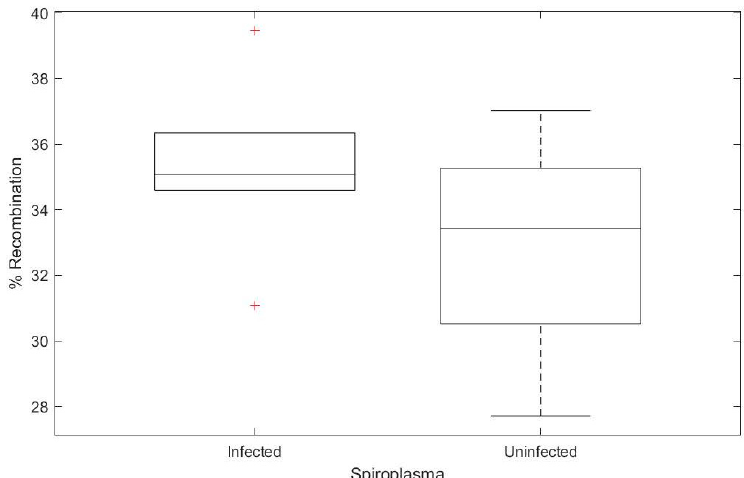
Figure 4. Spiroplasma infection does not increase the percentage of recombinants observed based on genetic markers on the X chromosome of Drosophila . Box and whisker plots showing that Spiroplasma infection did not significantly increase the observed recombination rate (df = 1, χ 2 = 0.057, p = 0.812). Genetic background for all flies was OreR-modENCODE.